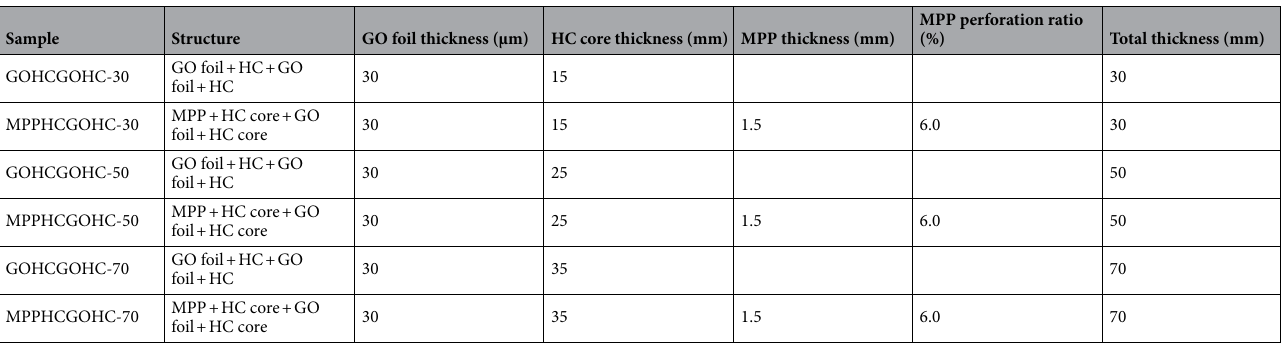
Table 2. Design parameters of proposed GOHCGOHC and MPPHCGOHC structures with different HC thickness.